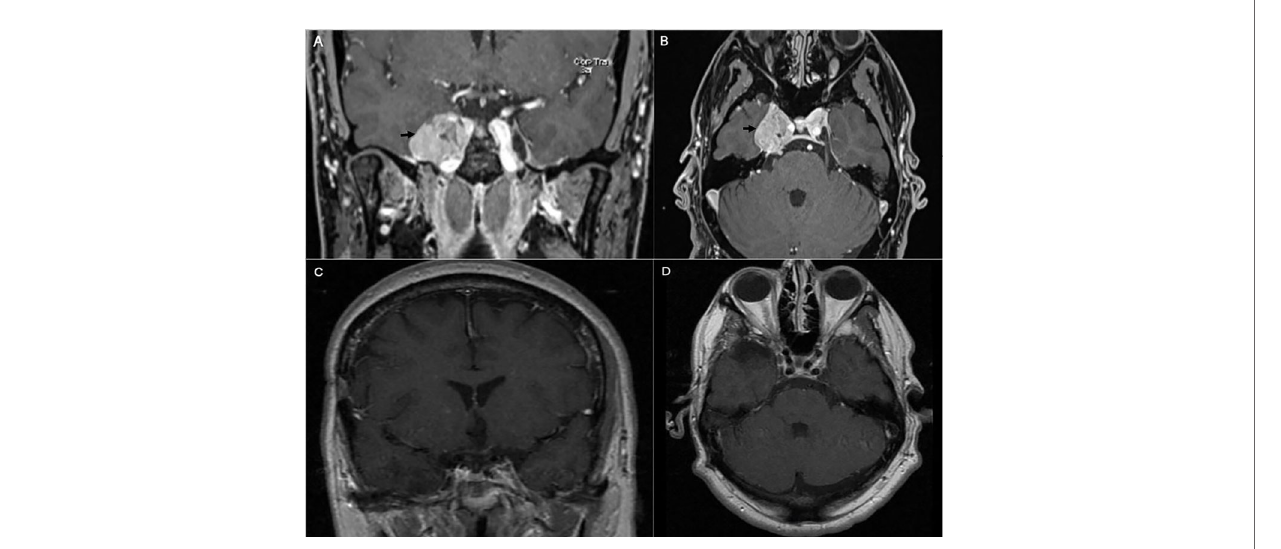
FIGURE 5 | Preoperative coronal (A) and axial (B) brain MRI with contrast showing heterogeneous enhancing tumor involving the right cavernous sinus (arrow). The patient is known to have right cavernous sinus meningioma for which he had stereotactic radiosurgery 4 years prior to presentation. Postoperative coronal (C) and axial (D) brain MRI with contrast showing gross total excision of the